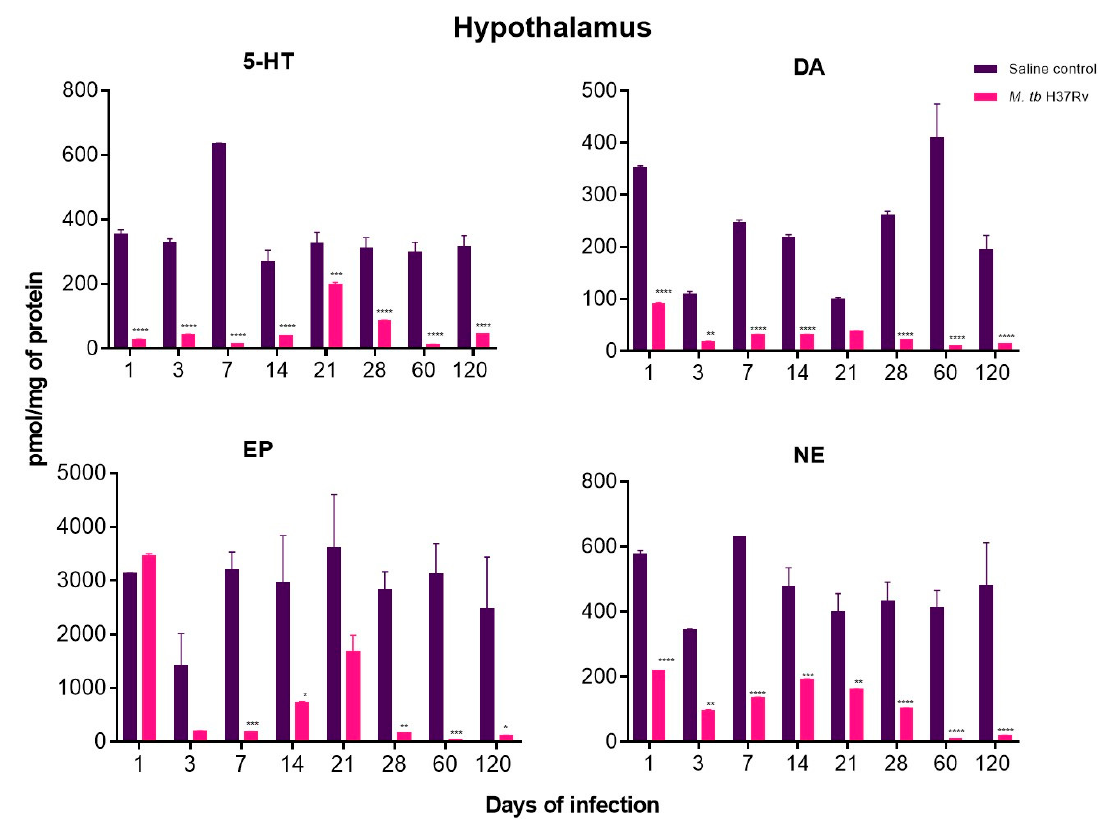
Figure 10. The concentration of the indicated neurotransmitter determined by HPLC in the hypothalamus of animals intratracheally infected with M. tb . Pulmonary TB mice showed a significant decrease in Norepinephrine (NE), Dopamine (DA), Epinephrine (EP) and 5-HT from day one of infection. Data are expressed as mean ± SEM. The following were used: 5-HT F (1, 4) = 3570, p < 0.0001, two-way ANOVA; *** p < 0.0003, **** p < 0.0001, Sidak’s multiple comparisons test ( α = 0.05) ( n = 6). DA F (1, 4) = 630.9, p < 0.0001, two-way ANOVA; ** p < 0.0091, **** p < 0.0001, Sidak’s multiple comparisons test ( α = 0.05) ( n = 6). EP F (1, 4) = 512.6, p < 0.0001, two-way ANOVA; * p < 0.0113, ** p < 0.0032, *** p textless 0.0006, Sidak’s multiple comparisons test ( α = 0.05) ( n = 6). NE F (1, 4) = 443.9, p < 0.0001, two-way ANOVA; ** p < 0.0029, **** p < 0.0001, Sidak’s multiple comparisons test ( α = 0.05) ( n =